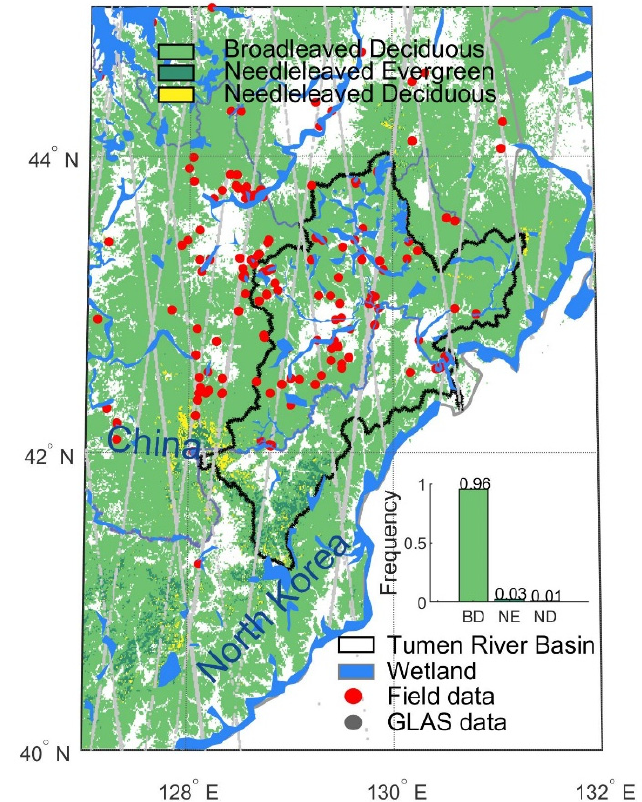
Figure 2. The forest type and wetland distribution of ESA CCI land cover data in the Tumen River Basin, where the red dots represent the location information of the measured sample points, and the gray dots represent the GLAS footprint trajectory.